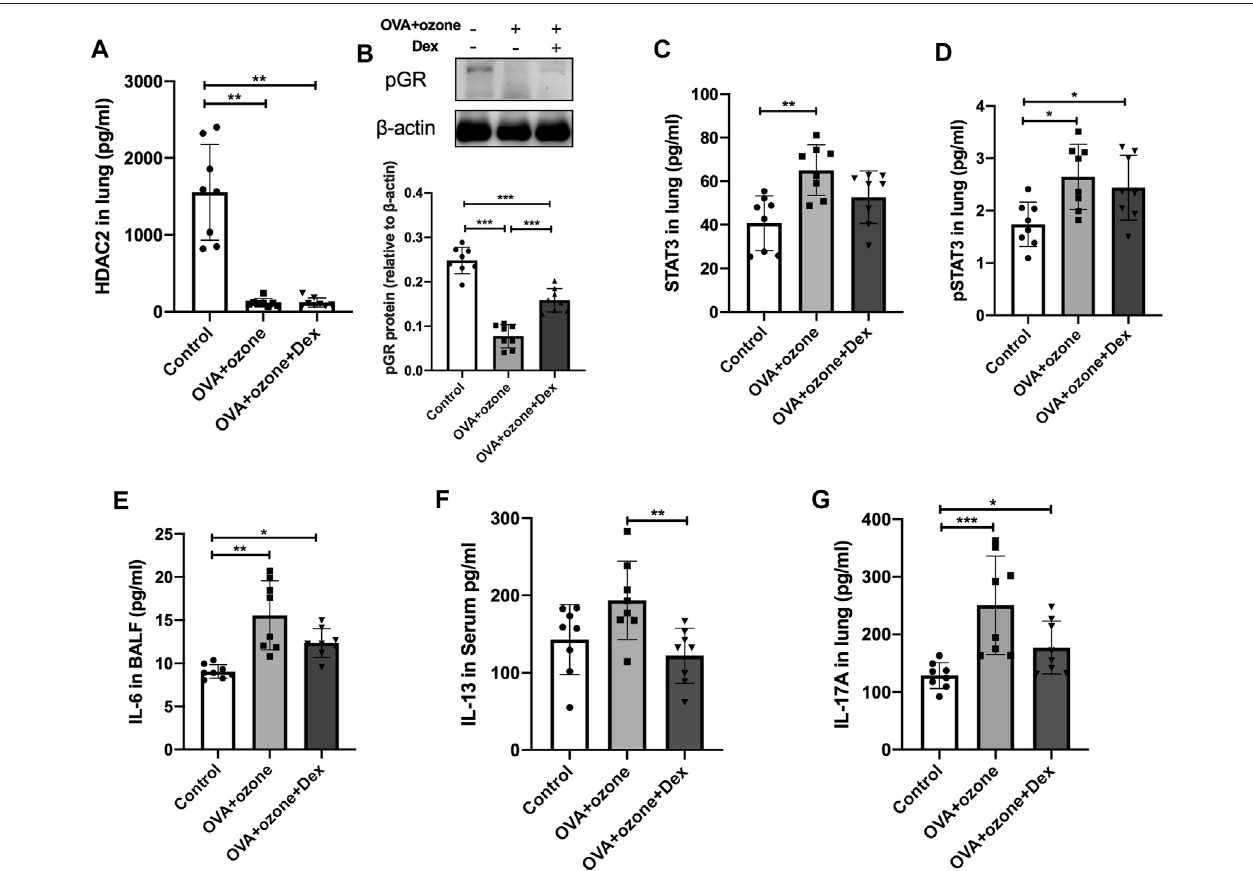
FIGURE 6 | Changes in the expression of cytokines and transcription factors after intervention by dexamethasone. The expression of HDAC2, IL-6, IL-13, and IL- 17AwasmeasuredbyELISAs.Theexpressionofp-GRproteinwasanalyzedbywesternblotting. (A) ExpressionofHDAC2proteininlungtissueafterDextreatment. (B) Expression of p-GR protein in lung tissue after Dex treatment. (C) Expression of STAT3 protein in lung tissue after Dex treatment. (D) Expression of p-STAT3 protein in lung tissueafterDextreatment. (E) ExpressionofIL-6proteininBALFafter Dextreatment. (F) ExpressionofIL-13protein afterDextreatment. (G) ExpressionofIL- 17A protein after Dex treatment. Dex, dexamethasone; HDAC2, histone deacetylase 2; p-GR, phosphorylated-GR; STAT3, signal transducer and activator of transcription 3.* p < 0.05; ** p < 0.01; *** p < 0.001.